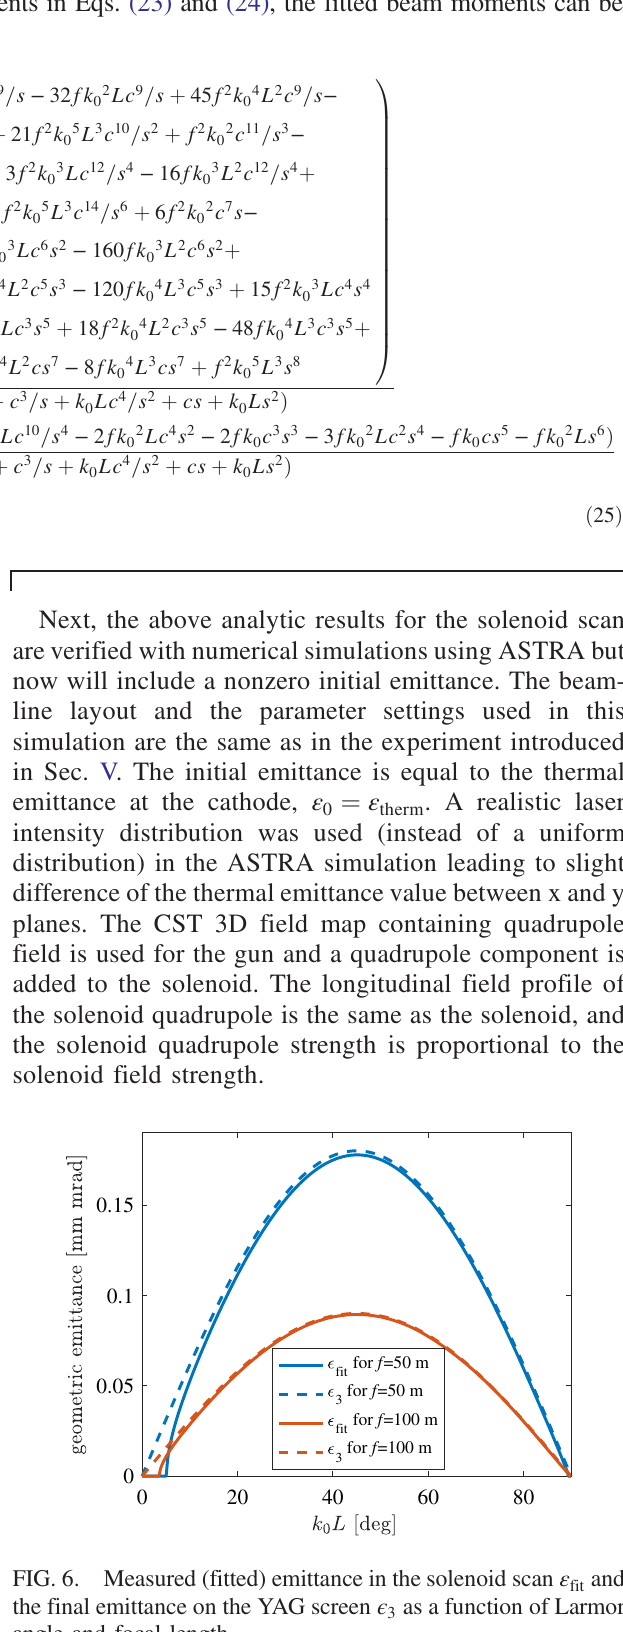
FIG. 6. Measured (fitted) emittance in the solenoid scan ε the final emittance on the YAG screen ϵ 3 as a function of Larmor angle and focal